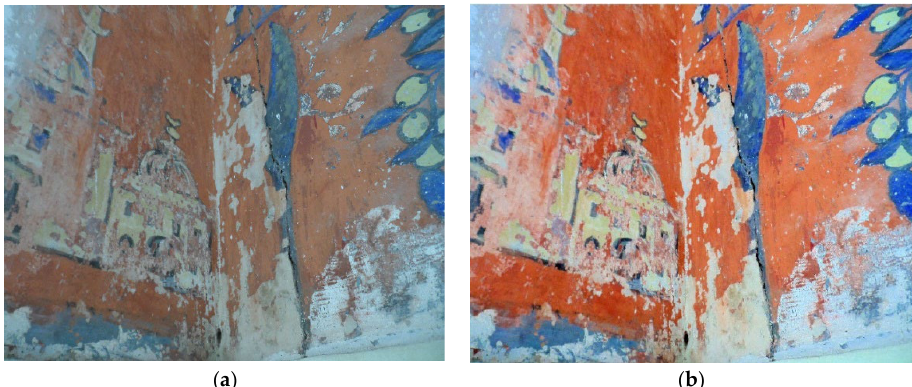
Figure 8. Display result of the dehazing method applied on mural painting of Haj Ahmed palace side-by-side, ( a ) input haze image, ( b ) output image.